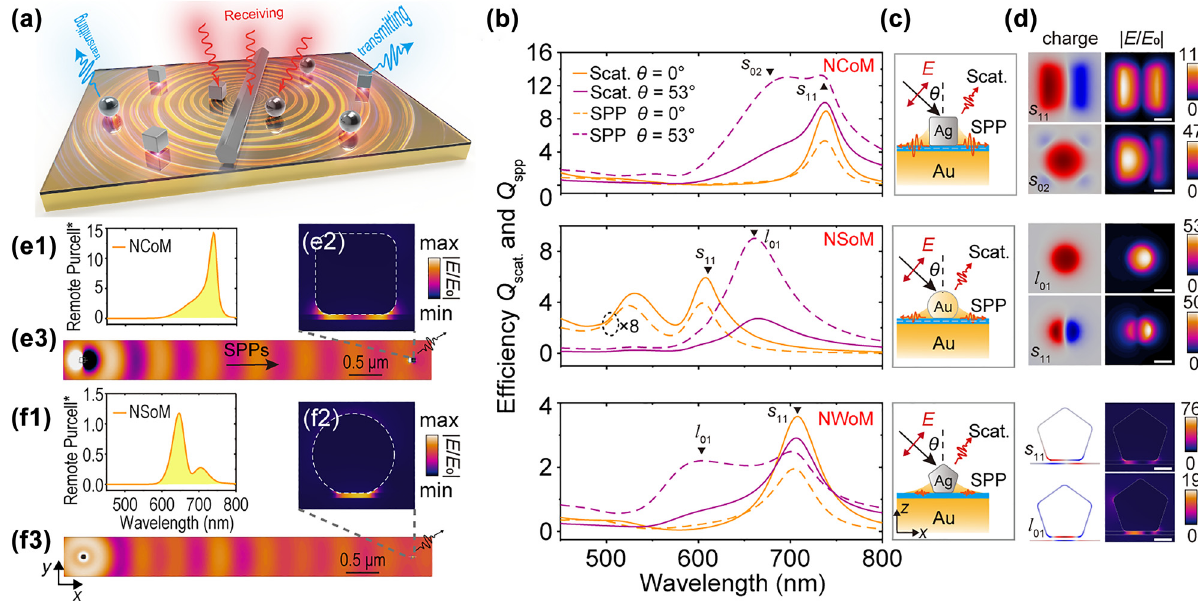
Figure 1: Optical properties of NPoM pairs family. (a) The schematic of NPoM pairs for remote spectroscopic purposes. Each kind of NPoM could be treated as receiving and transmitting antennas. (b) The efficiencies of scattering Q configurations: Upper panel (Ag NCoM), middle panel (Au NSoM), and lower panel (Ag NWoM). In (b), normal (yellow) and oblique (purple) incidences were checked and efficiencies of scattering (solid) and SPPs (dashed) were calculated. Schematics were shown in (c). (d) The charges and electric field enhancement of various resonances that occurred in (b). The charge and electric field of NPoM and NCoM were taken at the surface in the middle of the gap parallel to the film, while those of NWoM were from the xz- cross section. The white scalebars represent 25 nm. The remote sensing properties of NCoM (e1–e3) and NSoM (f1–f3) were indicated by their remote Purcell factors ( F the remote field (e2, e3, f2, f3) excited by a dipole in receiving